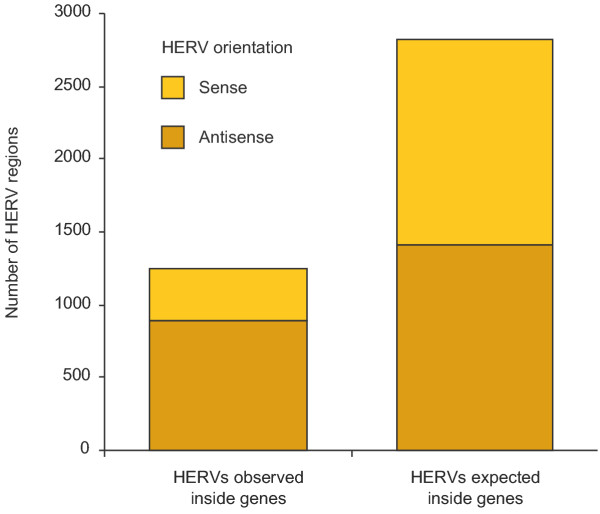
Number of HERV regions located inside genes, and their orientation relative to the gene. The expected number assumes a random genomic distribution.